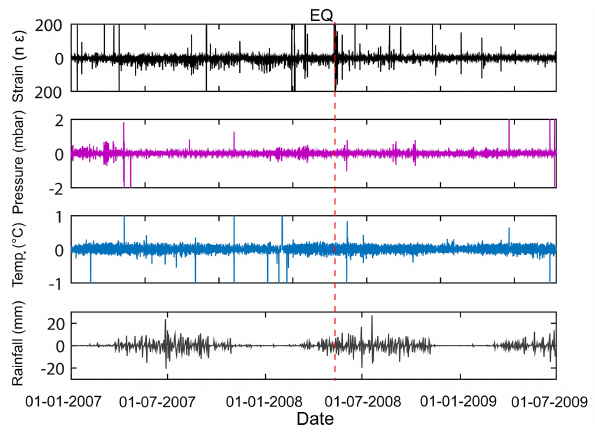
Figure 12. Differential borehole stain, air pressure, temperature and rainfall variations during study period at Guza